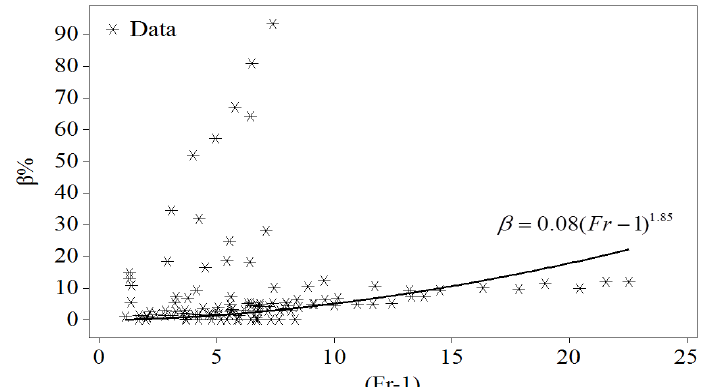
Figure 7. Illustration of the power relationship between the Froude number ( Fr ) and the aeration coefficient ( β ) of the applied experimental